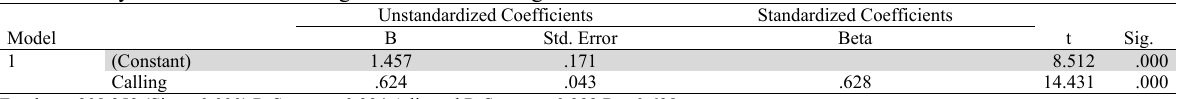
The summary of the effect of Calling on decision-making Model